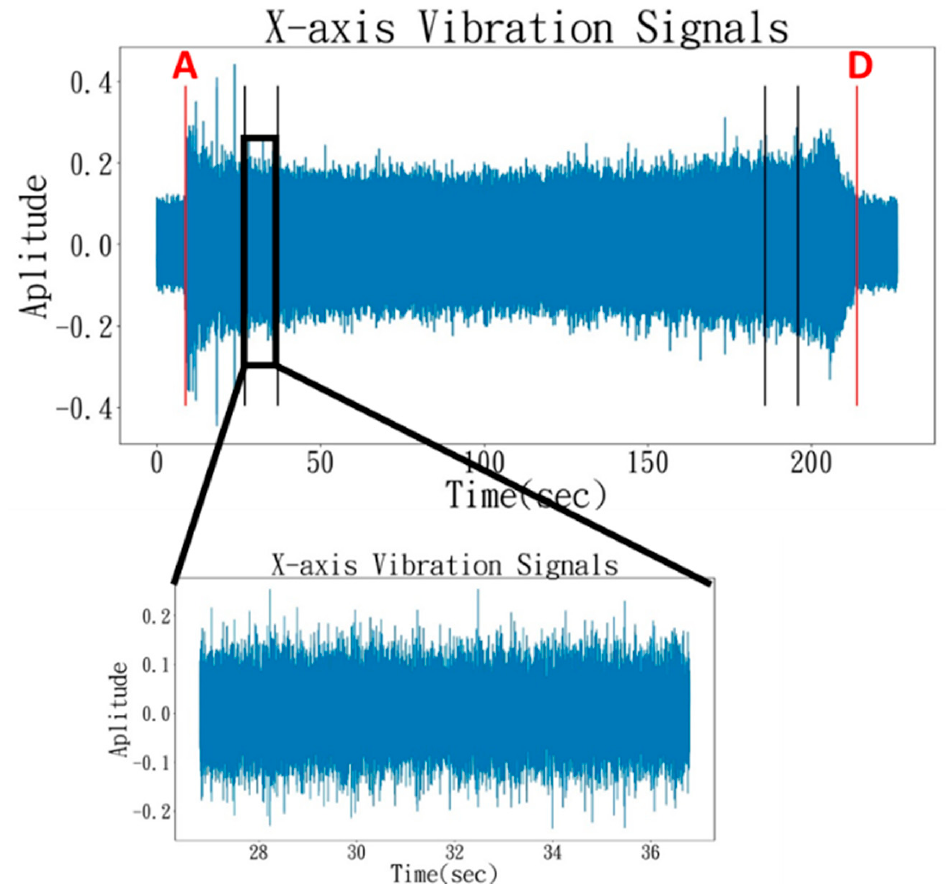
Figure 3. Split out of the head and tail signals in pre-processing stage.